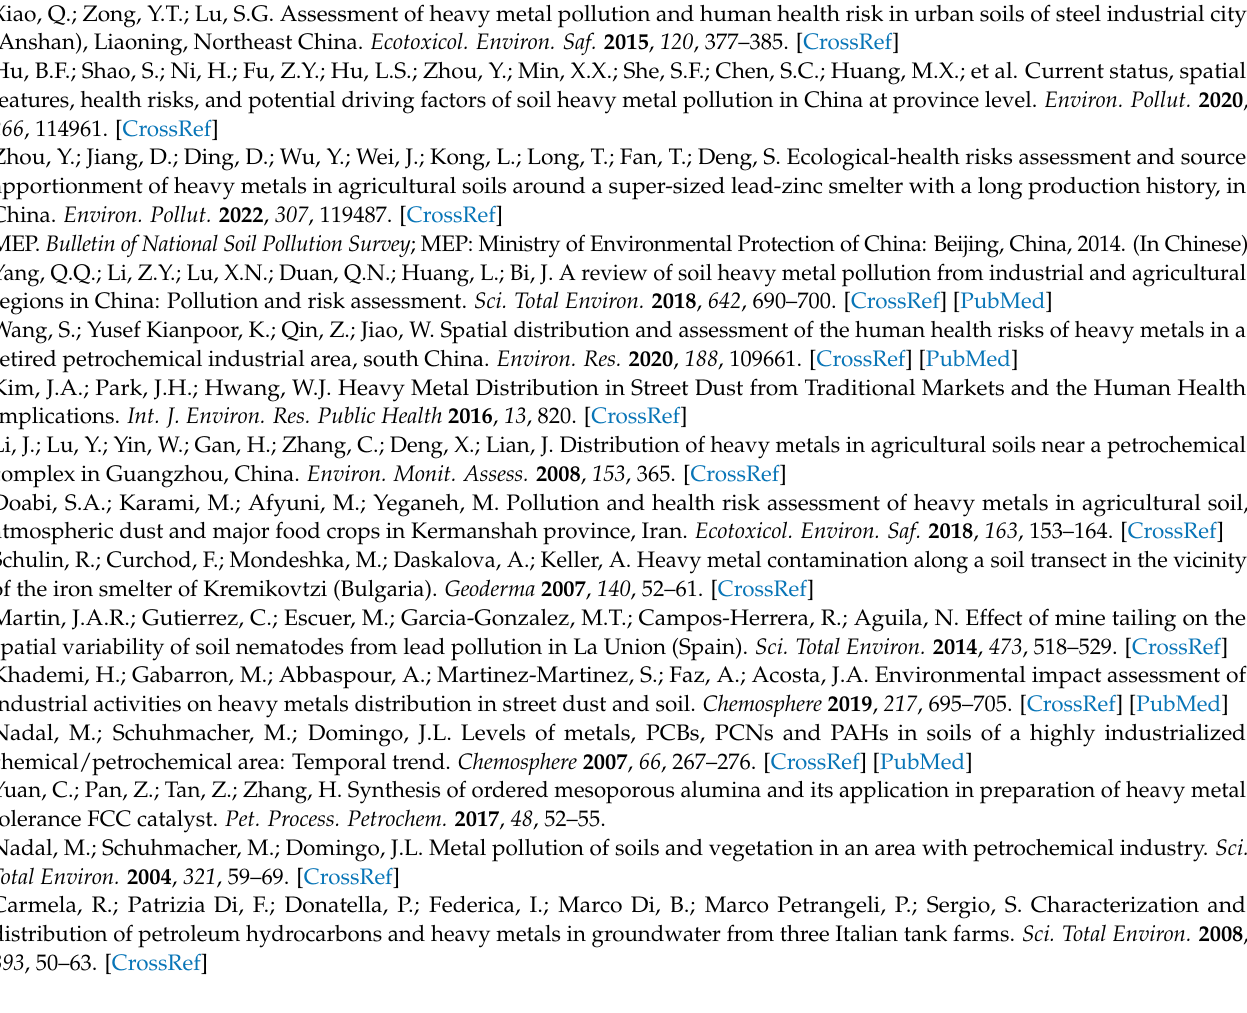
Table S6: concentrations (mg/kg) of HMs in soil samples in different studies; Table S7: descriptive Table S8: the proportion of different soil grades of HMs inside and around the petrochemical complex classified by I geo ; Table S9: the proportion of different soil grades of HMs inside and around the petrochemical complex classified by PI and NPI; Table S10: correlations between twelve HM concentrations in soils [3,6,8,15,19,21,31,32,34–36,48,58,59,64,65]. Author Contributions: Conceptualization, M.Y, S.Z. and M.L; methodology, S.Z., M.L., B.T. and X.Y.; formal analysis, M.Y., S.Z. and M.L.; investigation, M.Y., M.L. and J.X.; data curation, M.Y. and M.L.; writing—original draft preparation, M.Y.; writing—review and editing, S.Z., M.L., G.L. the